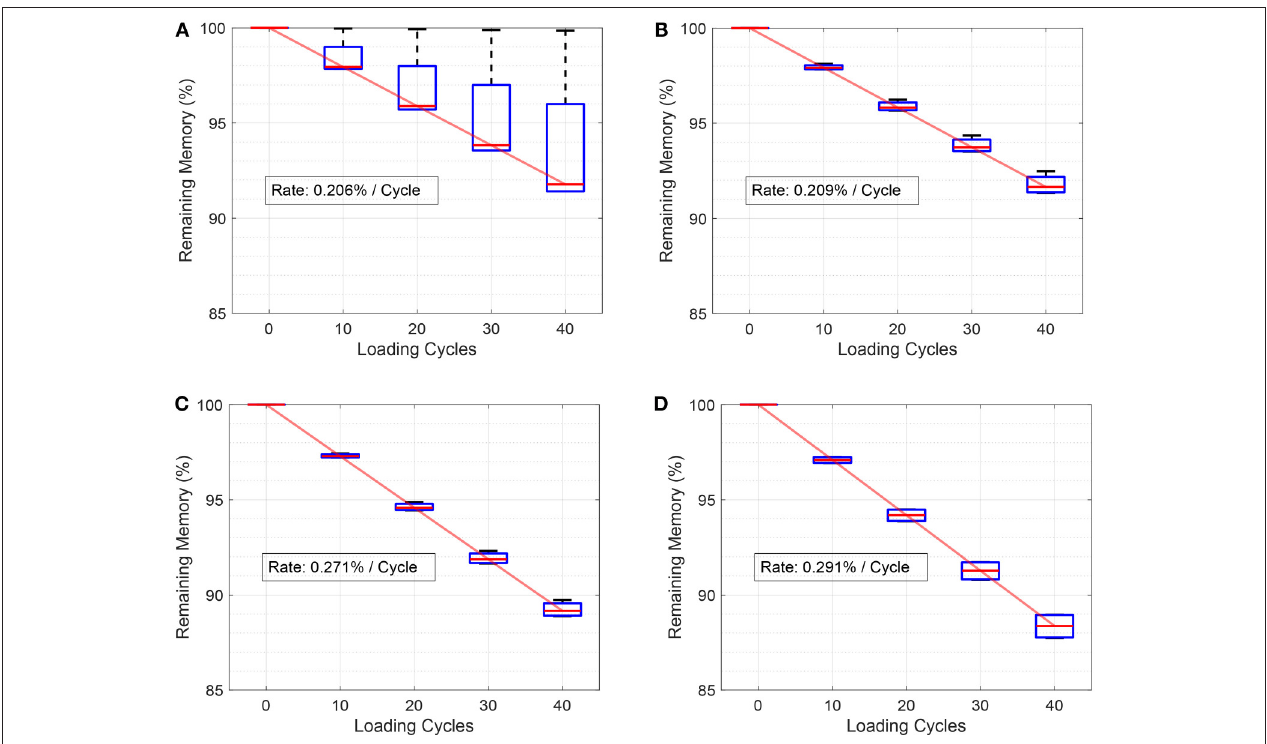
FIGURE 6 | Measured injection profiles for a prototype sensor on four separate floating-gates. Excluding one outlier, all four are in close agreement, and the median response follows a linear trend as expected. (A) Strain level 1, (B) Strain level 2, (C) Strain level 3, and (D) Strain level